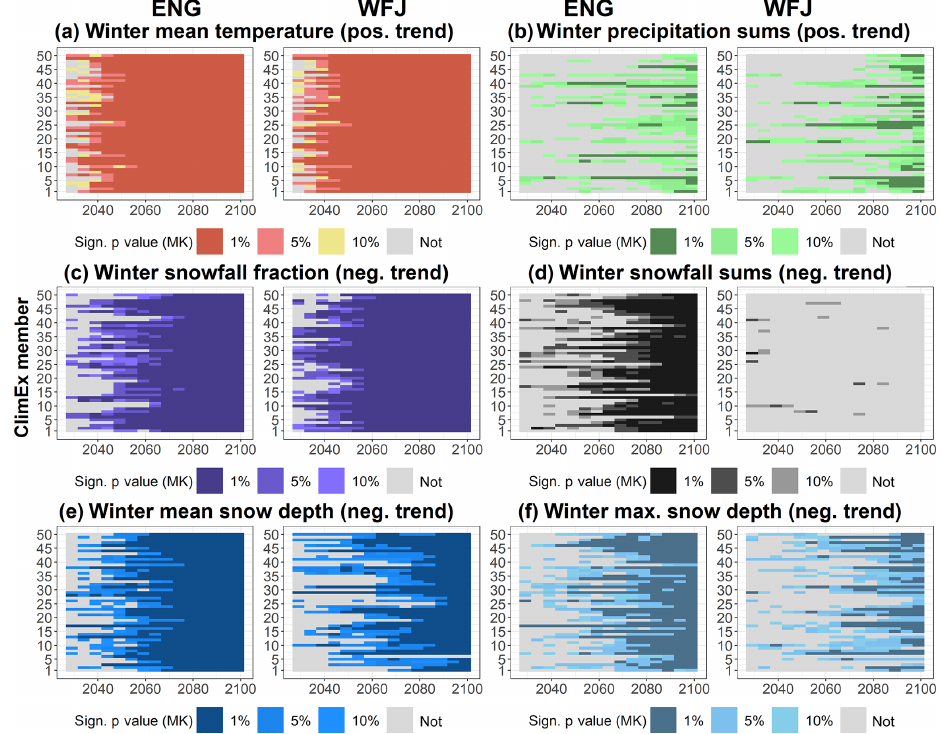
Figure 7. Heat maps of trend significance for the Mann–Kendall test for different periods starting in 2000 and ending between 2029 and 2099 for winter mean temperature, winter precipitation sums, winter snowfall fraction, winter snowfall sums, and winter mean and maximum snow depth for the lowest station, Engelberg (ENG), and the highest station, Weissfluhjoch